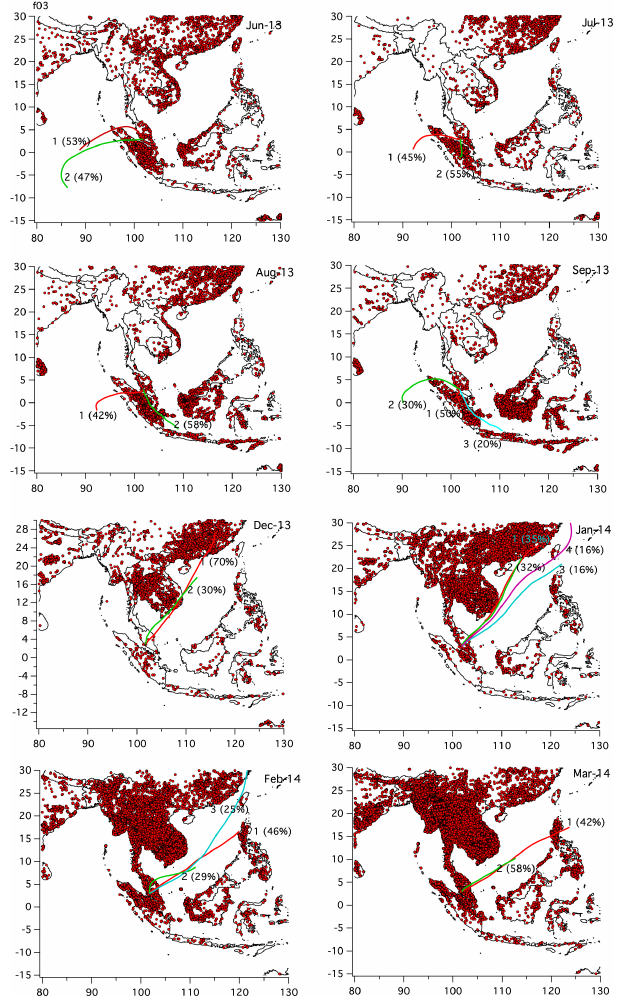
Figure 3. The location of biomass fire hotspots and the monthly mean cluster of backward trajectories by HYSPLIT 4.9 model for 120h and 500m releasing height starting from 16:00UTC during the south-west and the north-east